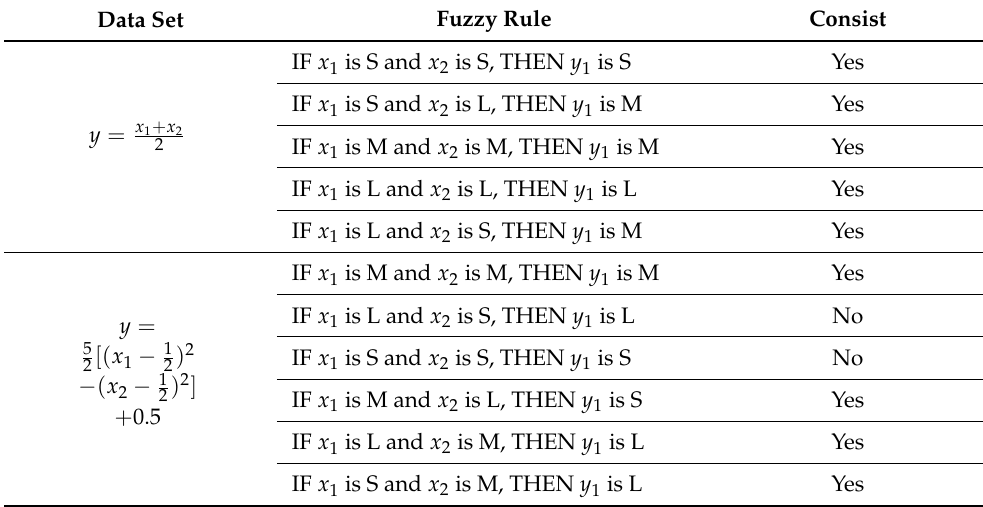
Table 5. Fuzzy rules generated for continuous data